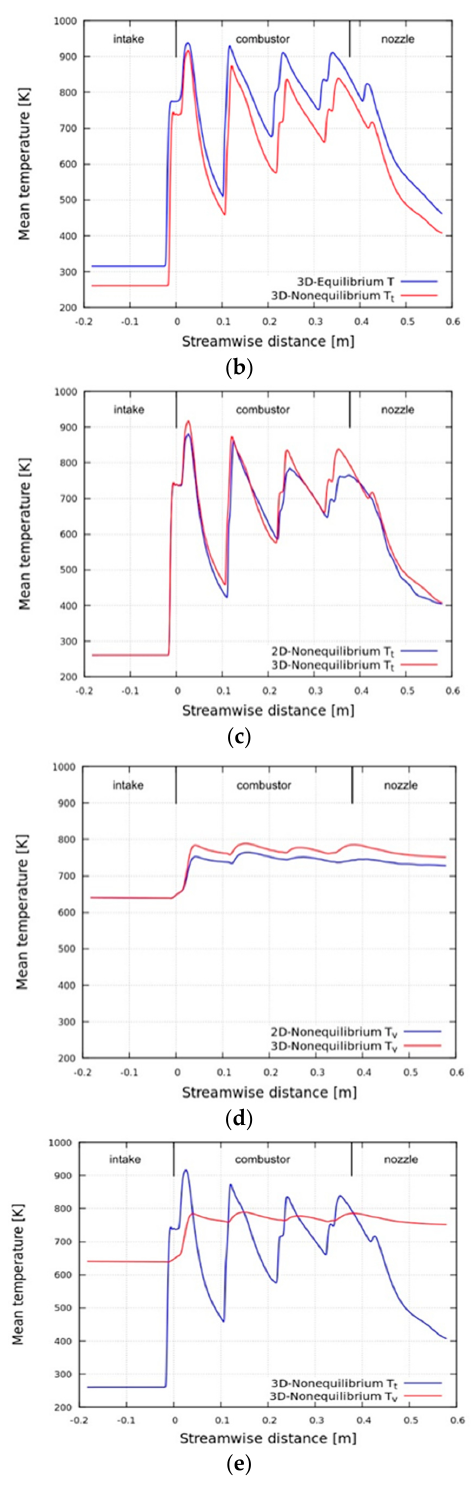
Figure 12. Distributions of temperature along the centerline ( y = 0, z = 0): ( a ) temperature of the equilibrium case and translational-rotational temperature of the nonequilibrium case for the 2D cases; ( b ) temperature of the equilibrium case and translational-rotational temperature of the nonequilibrium case for the 3D cases; ( c ) translational-rotational temperature of the nonequilibrium cases; ( d ) vibrational temperature of the nonequilibrium cases; ( e ) translational-rotational and vibrational temperature of the 3D-nonequilibrium case.